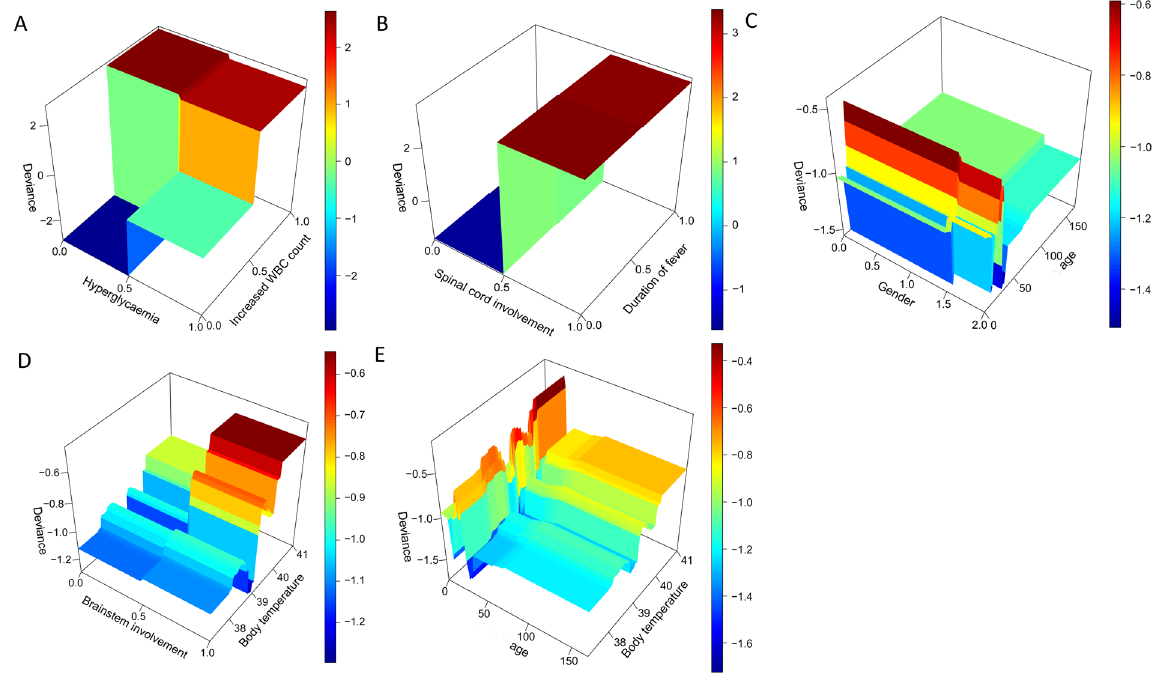
Figure 2. The interaction effect between two predictors. The x-axis denotes the status of the predictor. The y-axis (deviance) is a quality-of-fit statistic for the interaction that measures how well the new configuration fits the data. (In Fig. 2A, we can observe a significant increase in the risk of severe HFMD when the probability of increased WBC count and hyperglycemia changed from 0.5 to 1. In Fig. 2B, we can observe that conditioning on the change of spinal cord involvement, the effect of duration of fever ≥ 3 days is minor. In Fig. 2C, when the age is between 0 and 50 months and the patient is male, we can observe a significant increase risk of severe HFMD. In Fig. 2D, we can observe that if we fix the body temperature at 38 degree, then there is a slight increase in the risk of severe HFMD when the probability of brainstem involvement changed from 0 to 1. However, when the body temperature is between 40 and 41 degree, we can observe a significant increase in the risk of severe HFMD if the status of brainstem involvement changed. In Fig. 2E, when the body temperature is between 40 and 41 degree and the age is between 0 and 50 months, we can observe a significant increase risk of severe